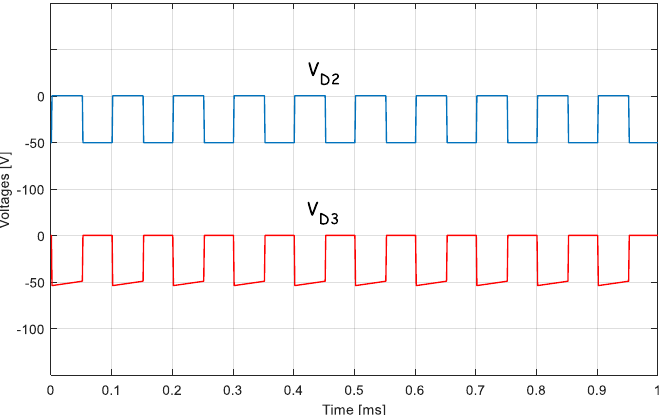
Figure 8. Simulation results of the voltage across the diodes D 2 and D 3 in buck mode.